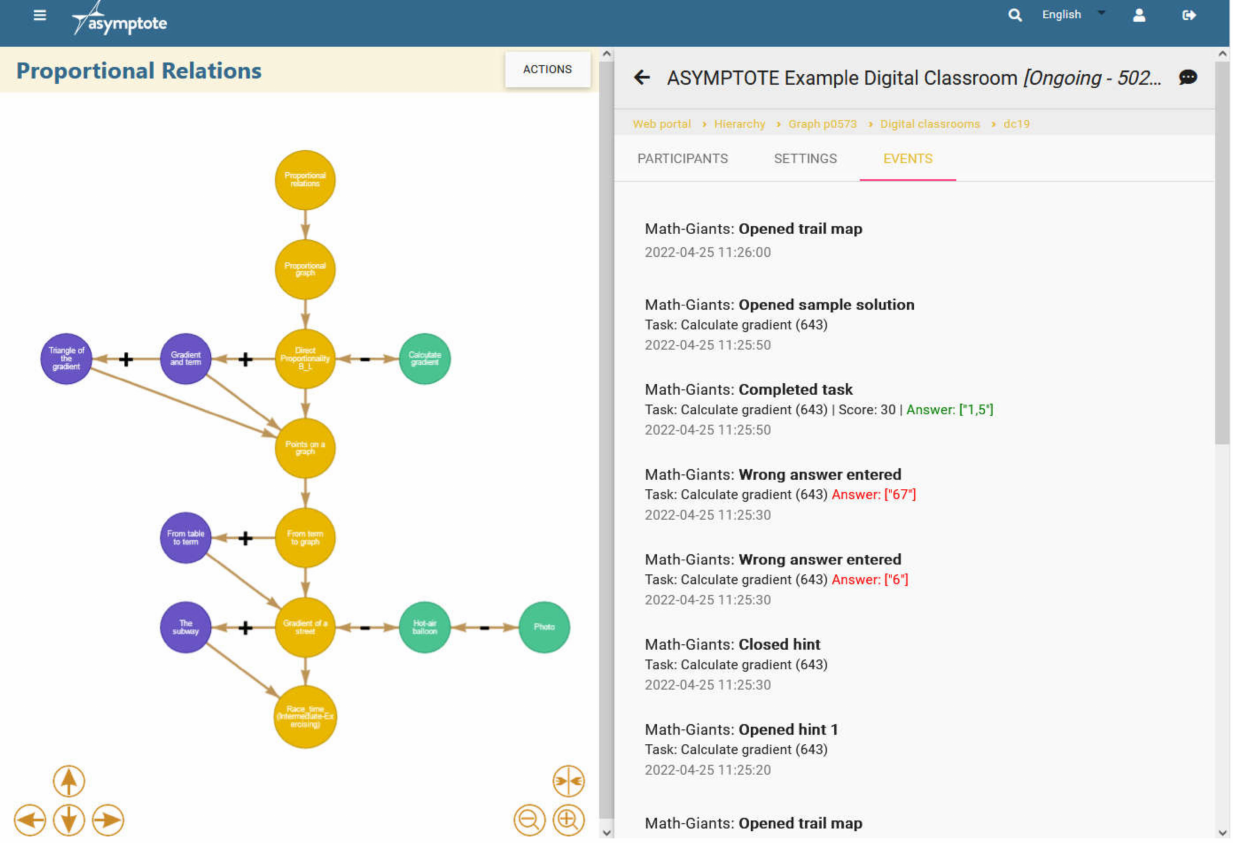
Figure 6. A prototypical learning graph ( left side ) and the related event log of a digital classroom session ( right side ): Within the event log, teachers can observe all student activities, such as given answers, viewed hints, and sample solutions. This view is preliminary and will be extended with further analytic